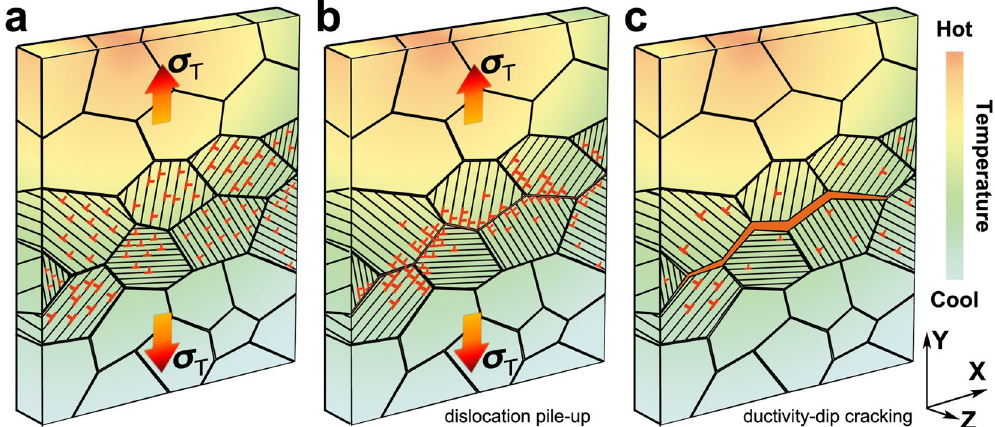
Figure 6. Possible schematic of the crack formation mechanism induced by thermal stress. ( a ) Sample under thermal stresses in the possible directions induced by temperature gradient, with dislocations activated mainly in the XZ plane. ( b ) Dislocations pile-up at the GBs, resulting in high deformation locally. ( c ) Void and crack formation caused by elevated local